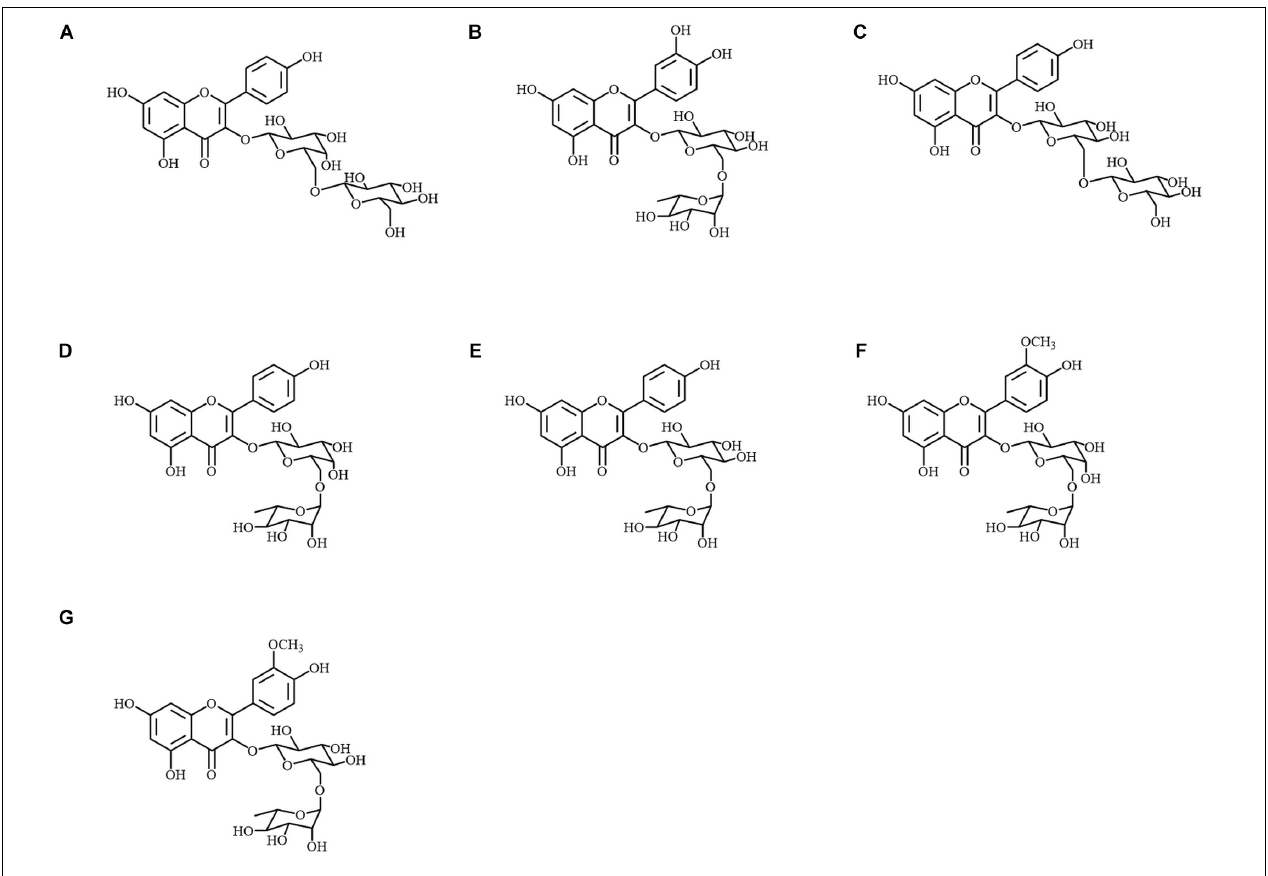
FIGURE 3 | Chemical structures of metabolites A–G isolated from Peking. (A) Kaempferol 3- O -glucosyl-(1 → 6)-galactoside; (B) quercetin 3- O -rutinoside; (C) kaempferol 3- O -gentiobioside; (D) kaempferol 3- O -robinobioside; (E) kaempferol 3- O -rutinoside; (F) isorhamnetin 3- O -robinobioside; (G) isorhamnetin 3- O